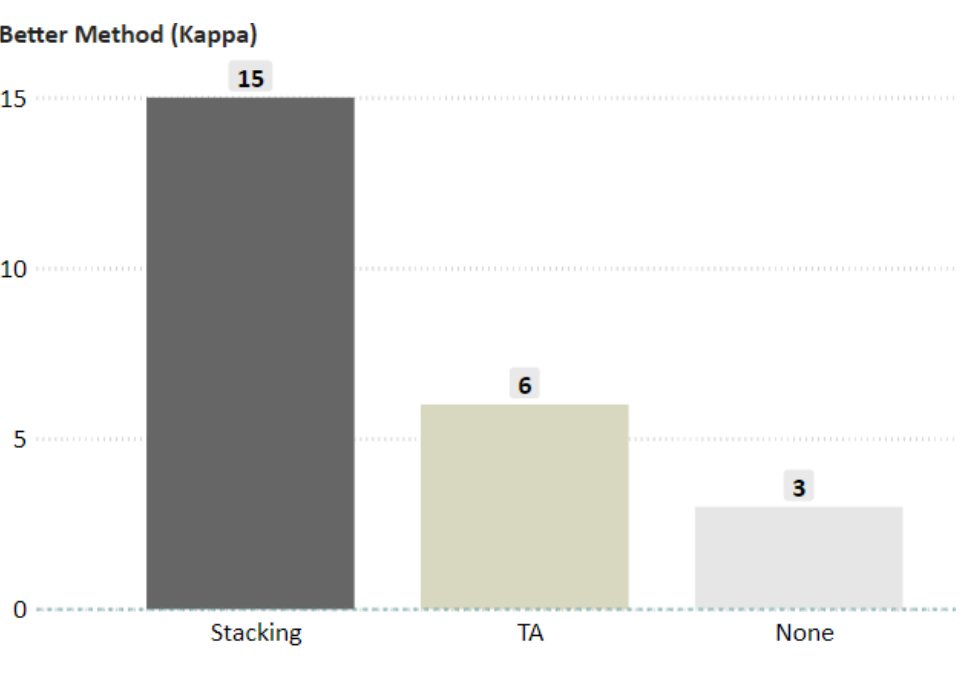
Figure 4. Number of OHSUMED datasets (Table 1) where each method (Stacking or Title-Abstract TA) was statistically better, or None if there is no statistical